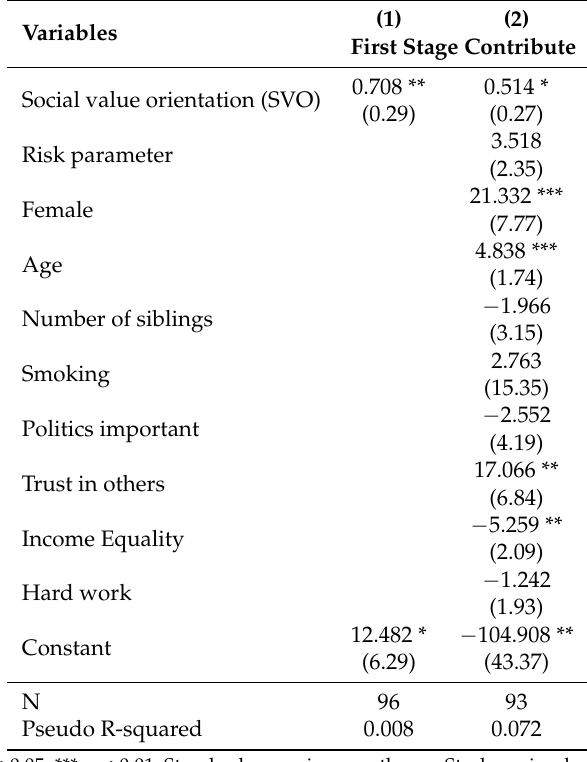
Table 1. Determinants of stage 1 contribution. Tobit model with limits at 0 and